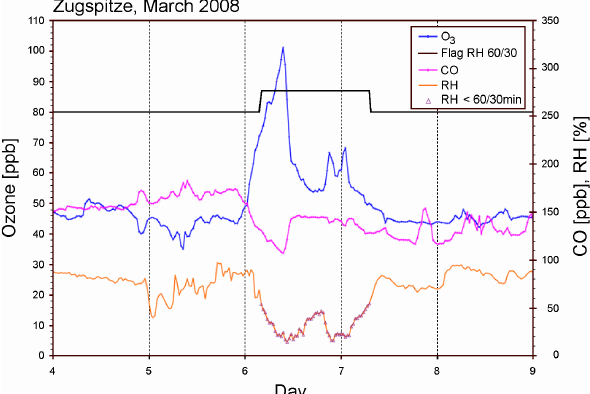
Fig. 4. Zugspitze ozone, carbon monoxide, and relative humidity (RH) in early March 2008; the Figure 4. Zugspitze ozone, CO and RH in early March 2008; the range of elevated values in the black top trace indicates the zone of STT according to filtering range of elevated values in the black top trace indicates the period Criterion 2 of (Trickl et al., 2010), i.e., RH < 60 % and RH < 30 % within the adjacent 6 h. The of STT according to filtering Criterion 2 of (Trickl et al., 2010), violet triangles on the RH curve also mark the time period during which Criterion 2 was valid. i.e. RH < 60% and RH < 30% within the adjacent 6h. The violet Despite the remarkable ozone rise the carbon monoxide mixing ratio stays far above full triangles on the RH curve also mark the time period during which stratospheric values of 20 to 40 ppb. Criterion 2 was valid. Despite the remarkable ozone rise, the CO mixing ratio stays far above full stratospheric values of 20 to